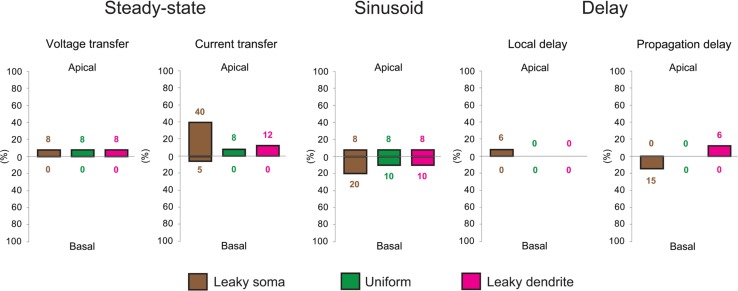
Aβ-driven alterations in steady-state current- and voltage transfers, 50 Hz sinusoid voltage transfers and local- and propagation delays of PSPs in TG neurons relative to control, WT neurons. Comparisons of dendritic impulse propagation were summarized in the leaky soma (brown), uniform (green) and leaky dendrite (magenta) membrane models. Size of bars illustrates the percentage differences between WT and TG neurons in certain features of dendritic impulse propagation. Upper and lower extensions of bars show the size of differences in properties of apical and basal arbors of WT and TG neurons. Data summarized here are based on comparison graphs shown in Supplementary Figures S1–S5.